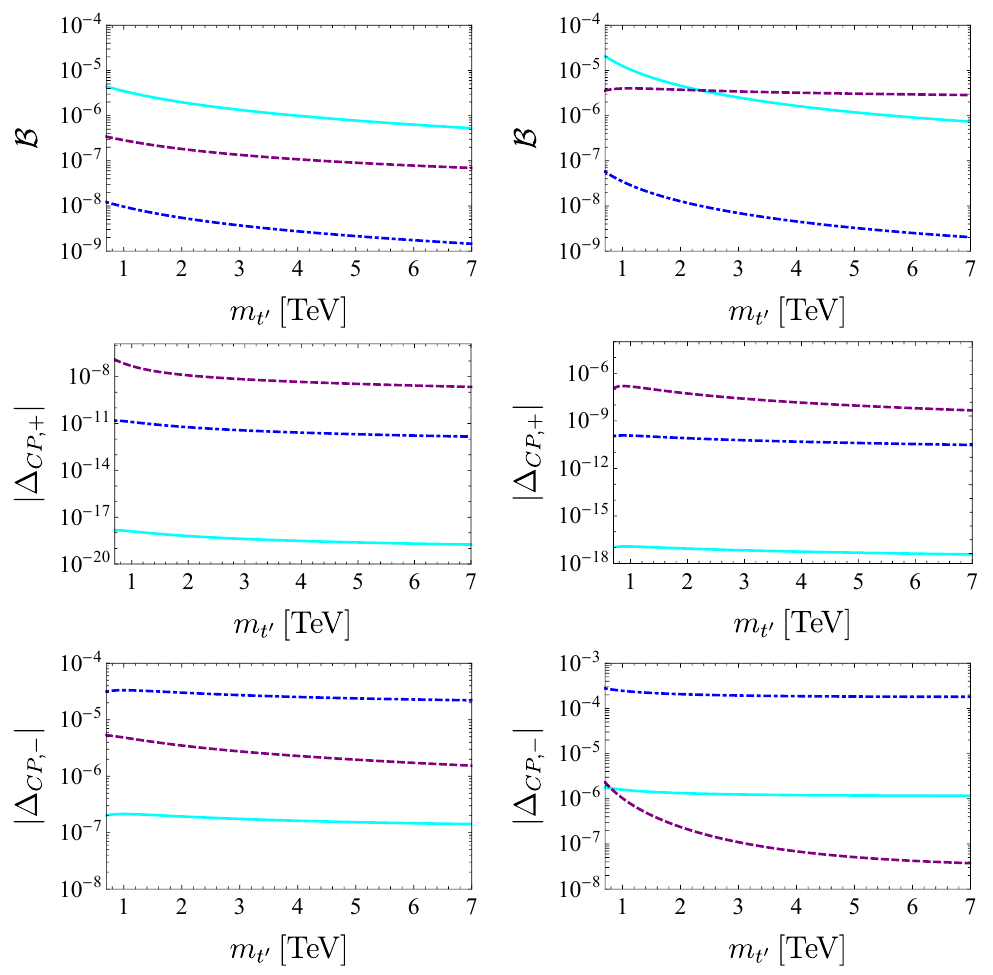
Figure 2 . The branching ratio (top panels), the | ∆ CP, + | asymmetry (middle panels) and | ∆ CP, − | asymmetry (bottom panels) for the radiative decays of t 0 . The left (right) panels are for radiative decays with a final state photon (gluon). The solid, dot-dashed and dashed lines correspond to t 0 decay channels with a u , c and t quark final state respectively shown as a function of the vector-like quark mass m t 0 . The low χ 2 benchmark mixing parameters shown in eq. (3.3) are used while m t 0 = [0 . 7 , 7]